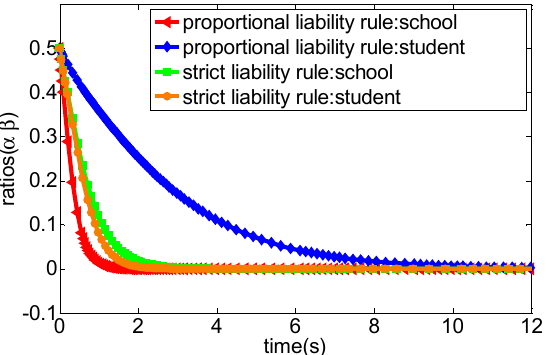
Figure 2. The evolution process of the system game strategy under the condition of high prevention cost from both parties (case 1).